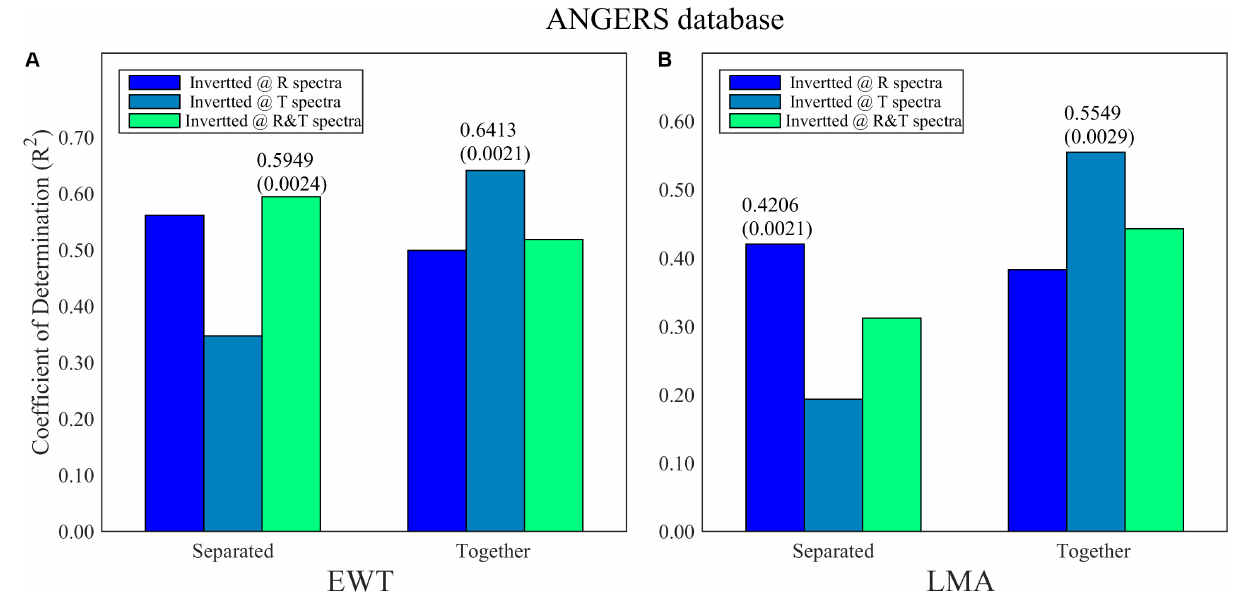
FIGURE 7 | The optimal R 2 and its corresponding RMSE (in bracket) of PCA-ANN models for (A) EWT and (B) LMA analysis being separated and together in ANGERS. A total of 753 bands reset and reordered from 2051 wavelengths are used. The PCs of analysis model are less than